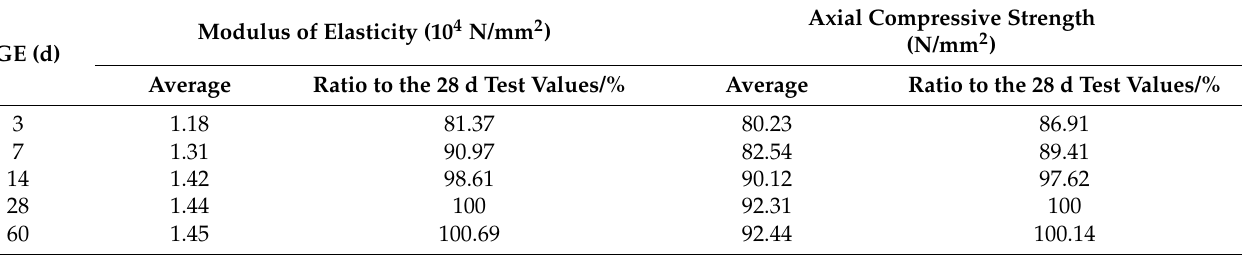
Table 9. Test values of the elastic modulus and axial compressive strength.